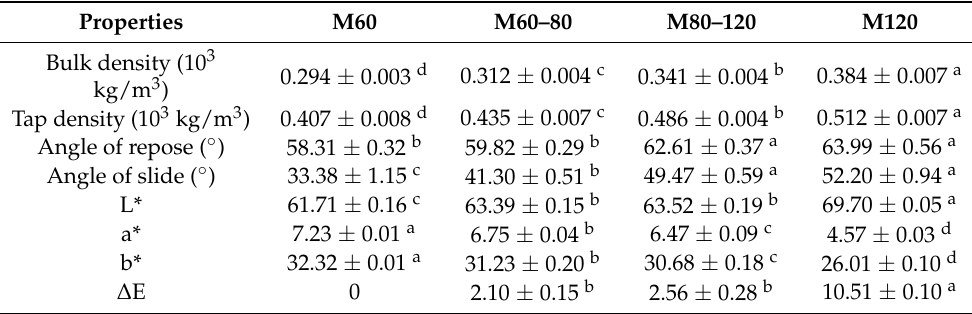
Table 3. The bulk and tap density, θ , α , and color of the different foxtail millet bran powders.